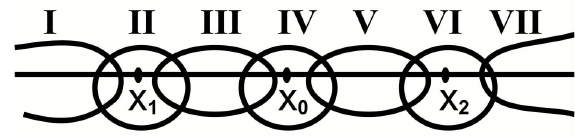
Fig. 2. The regions where the solutions of the wave equation have been